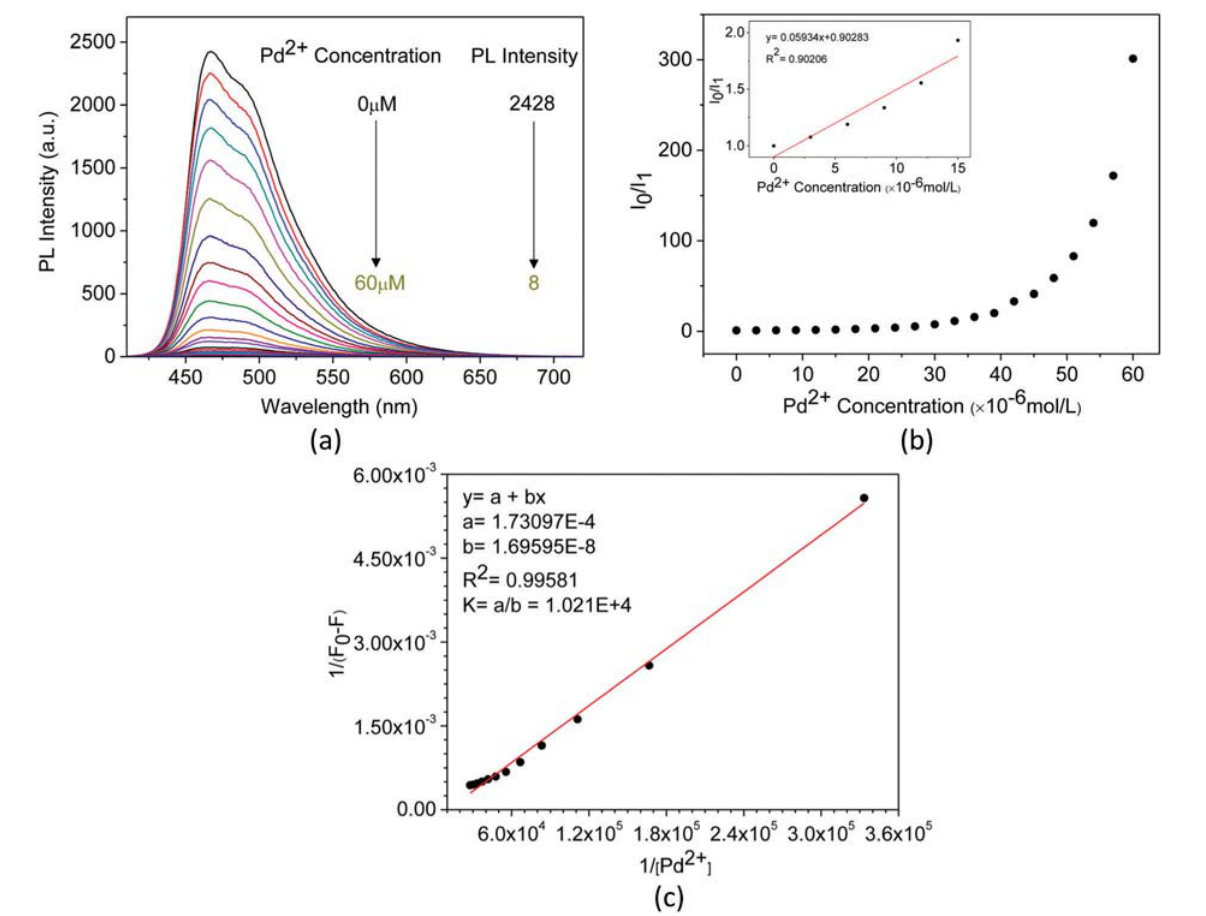
Figure 6: PL spectra of methanol solution of (+)-PPBIPV with different concentrations of Pd 2+ (a); PL titration curves of methanol solution of (+)-PPBIPV with Pd 2+ (b); The Benesi-Hildebrand plot of methanol solution of (+)-PPBIPV with Pd 2+ (c).